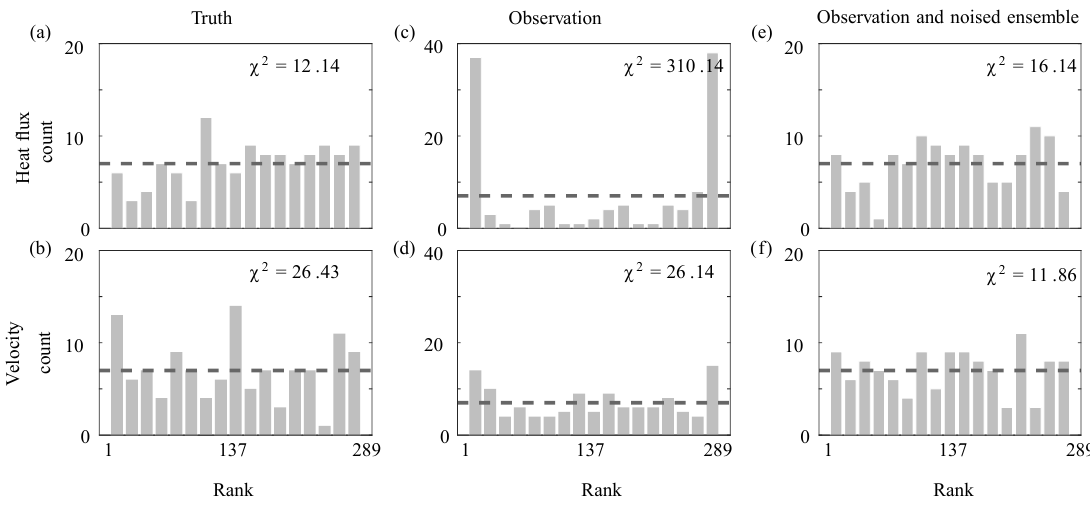
Figure 6. Rank histograms of the surface true heat flux (a) and velocity (b) as well as the surface observed heat flux (c) and velocity (d) , computed from the four evolutions of Fig. 2. The dashed lines represent the count for each bin if the rank histograms were